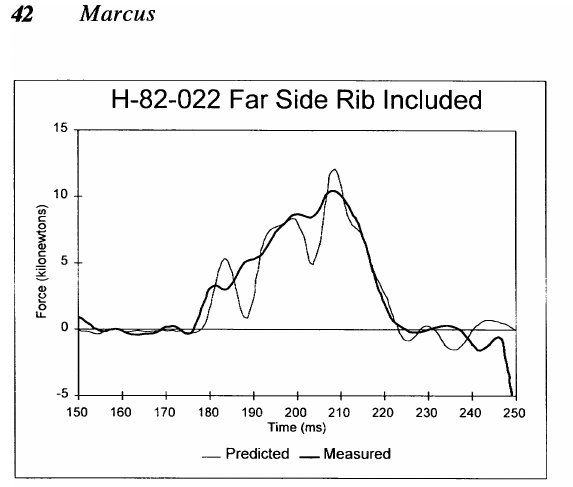
FIGURE 4 Measured and predicted forces using struck side rib, spine, and far side